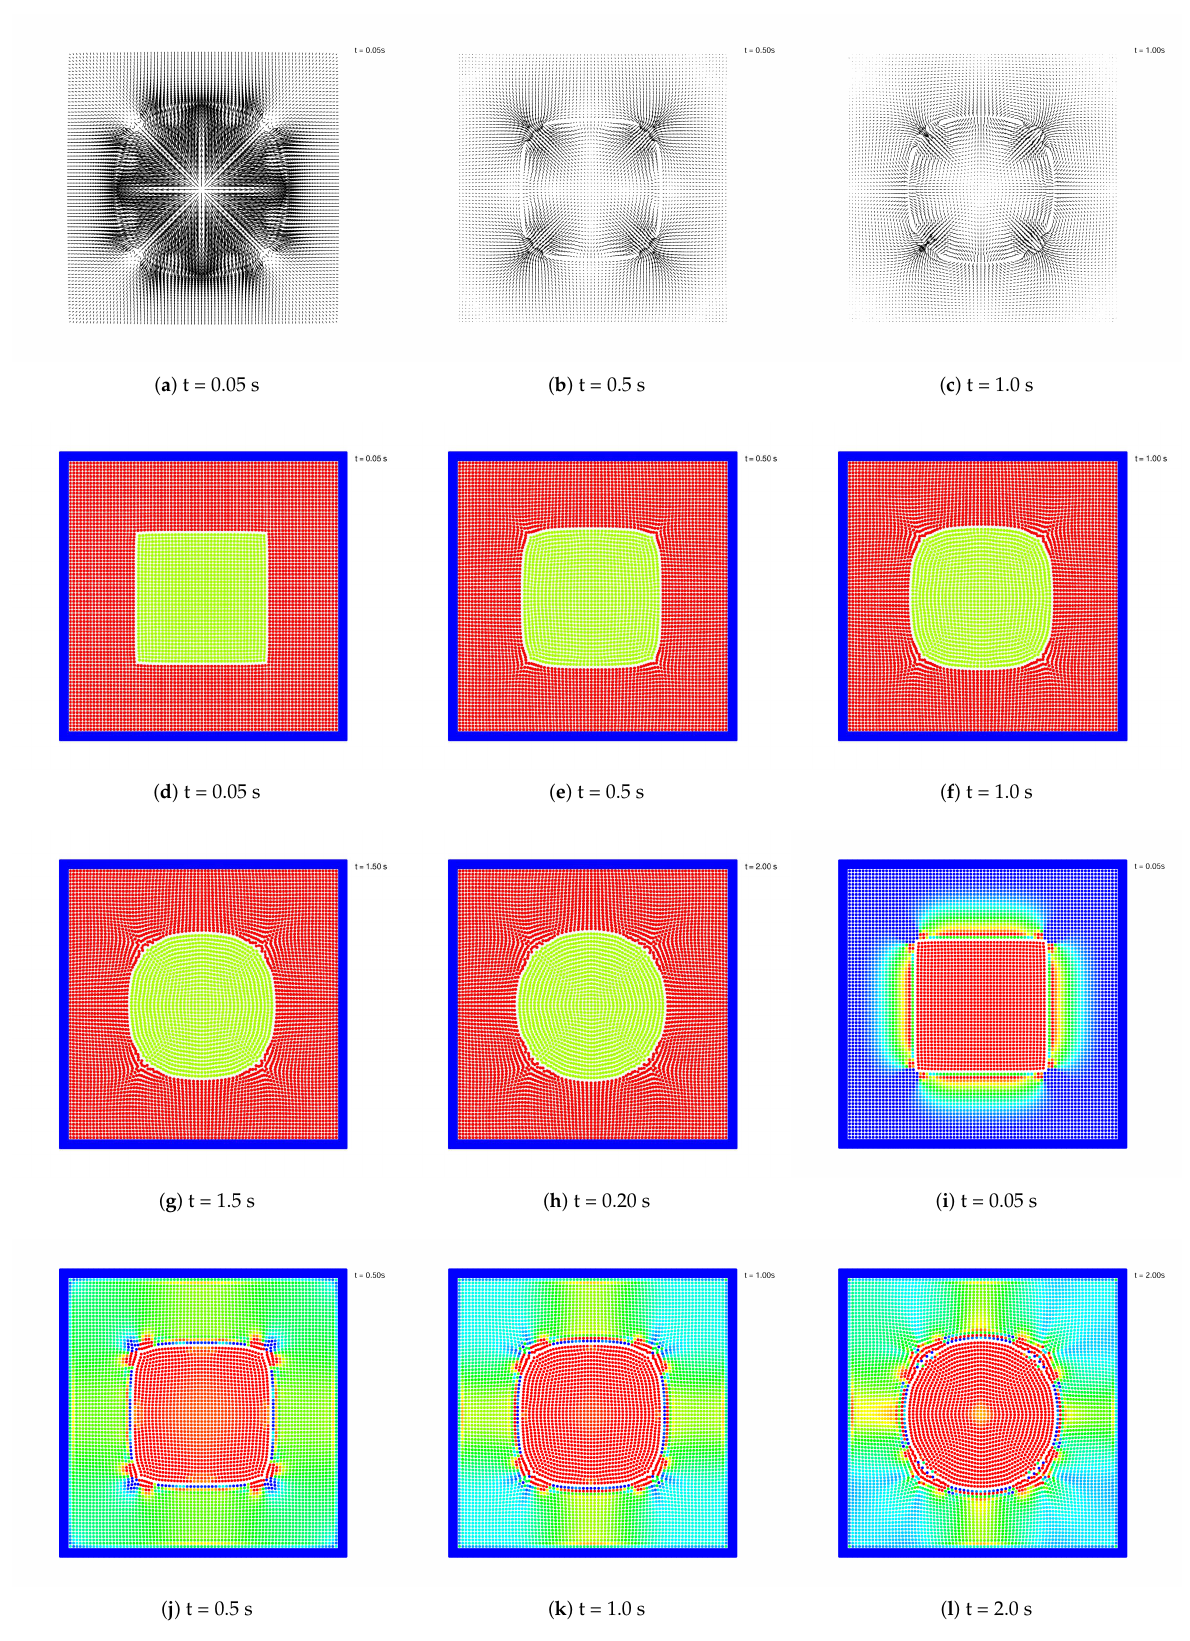
Figure 4. The evolutions of velocity ( a – c ), phase index ( d – h ), and pressure ( i – l ) of particles in the two-phase square